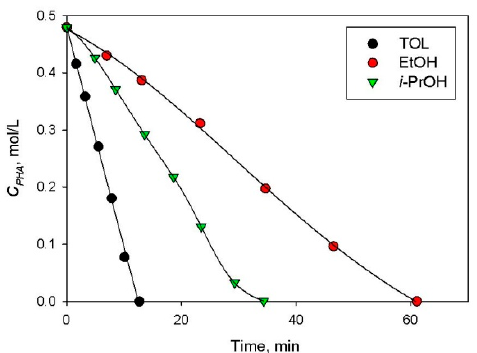
Figure 10. Scheme of selective hydrogenation of PHA to STY.